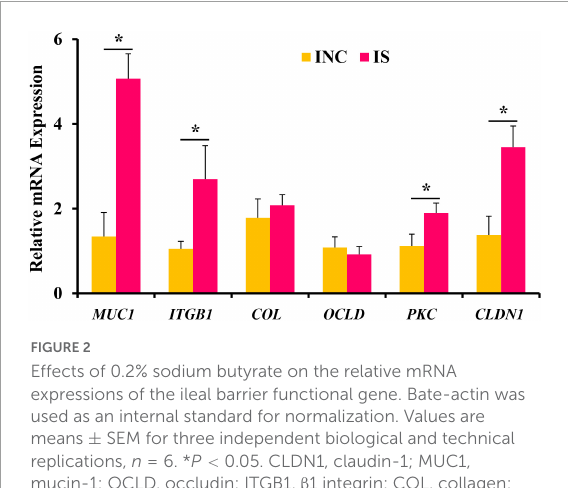
TABLE 4 Statistics of bacterial 16S rRNA gene amplicon sequencing for ileal and colonic content. a Group